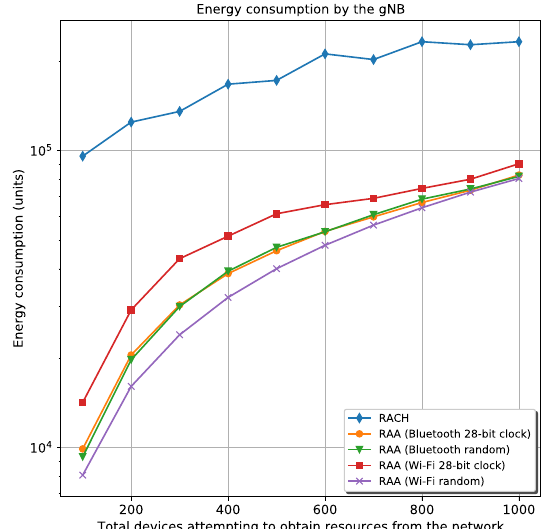
Figure 7. Total energy spent by the gNB for the classic RACH and four different RAA